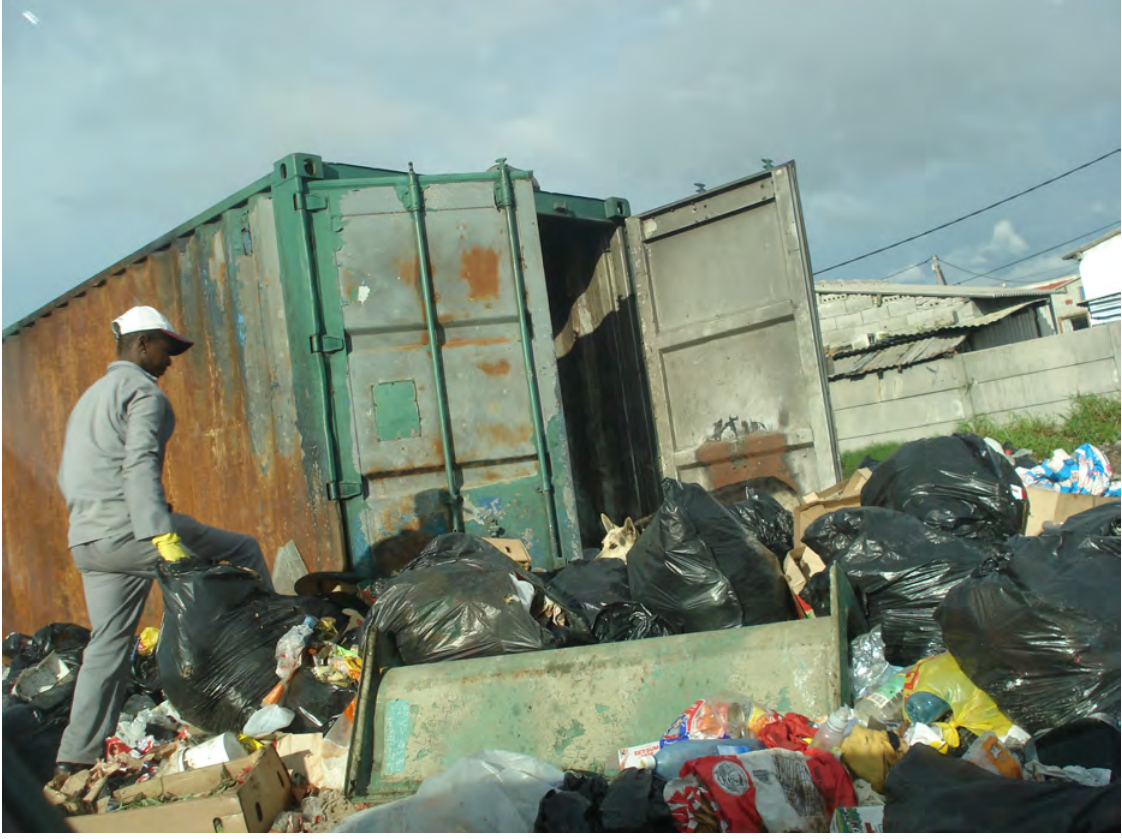
Figure 4: A lockable shipping container currently meant to be used by 400 dwellings